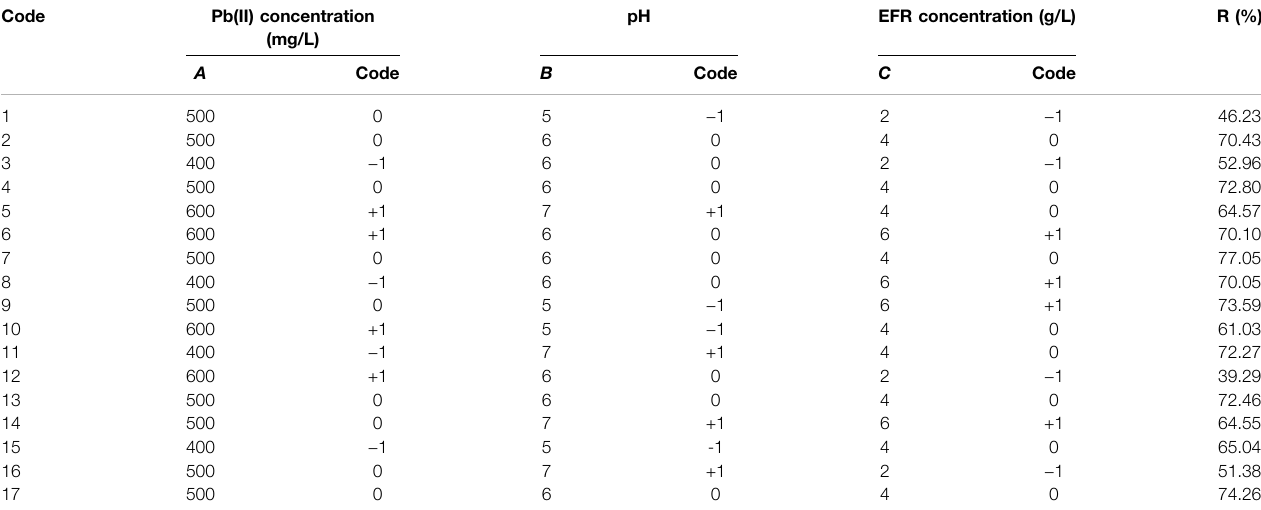
TABLE 2 | Box-Behnken experimental design with three independent variables. Code